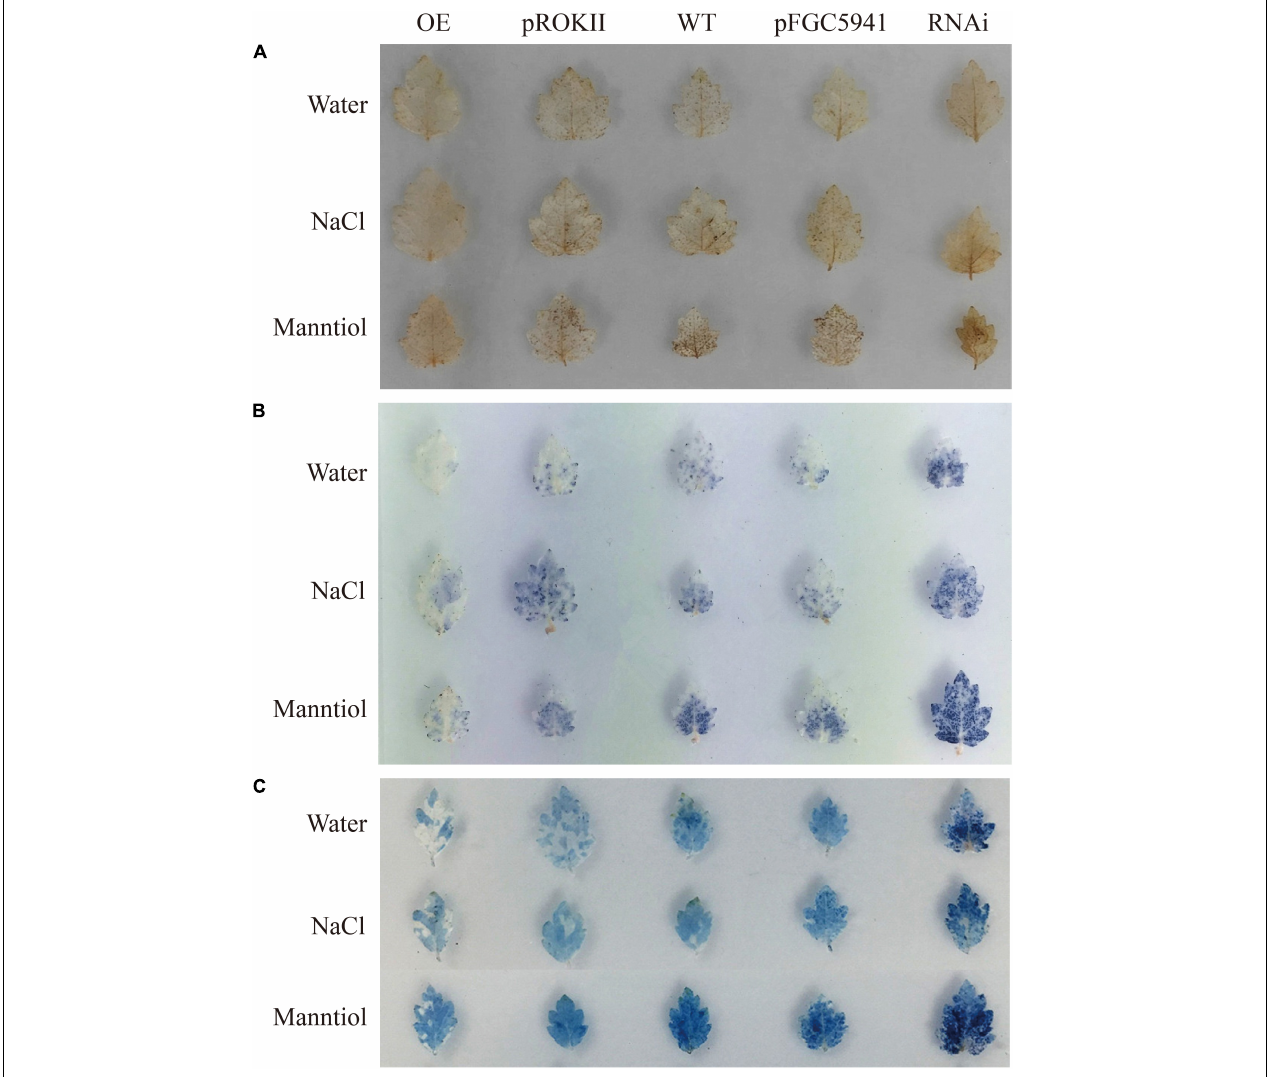
FIGURE 7 | Histochemical staining analysis of transiently transformed birch. The plants were stained with DAB (A) and NBT (B) to reveal the accumulation of O . − 2 and H 2 O 2 , respectively. (C) Analysis of cell death by Evan’s Blue